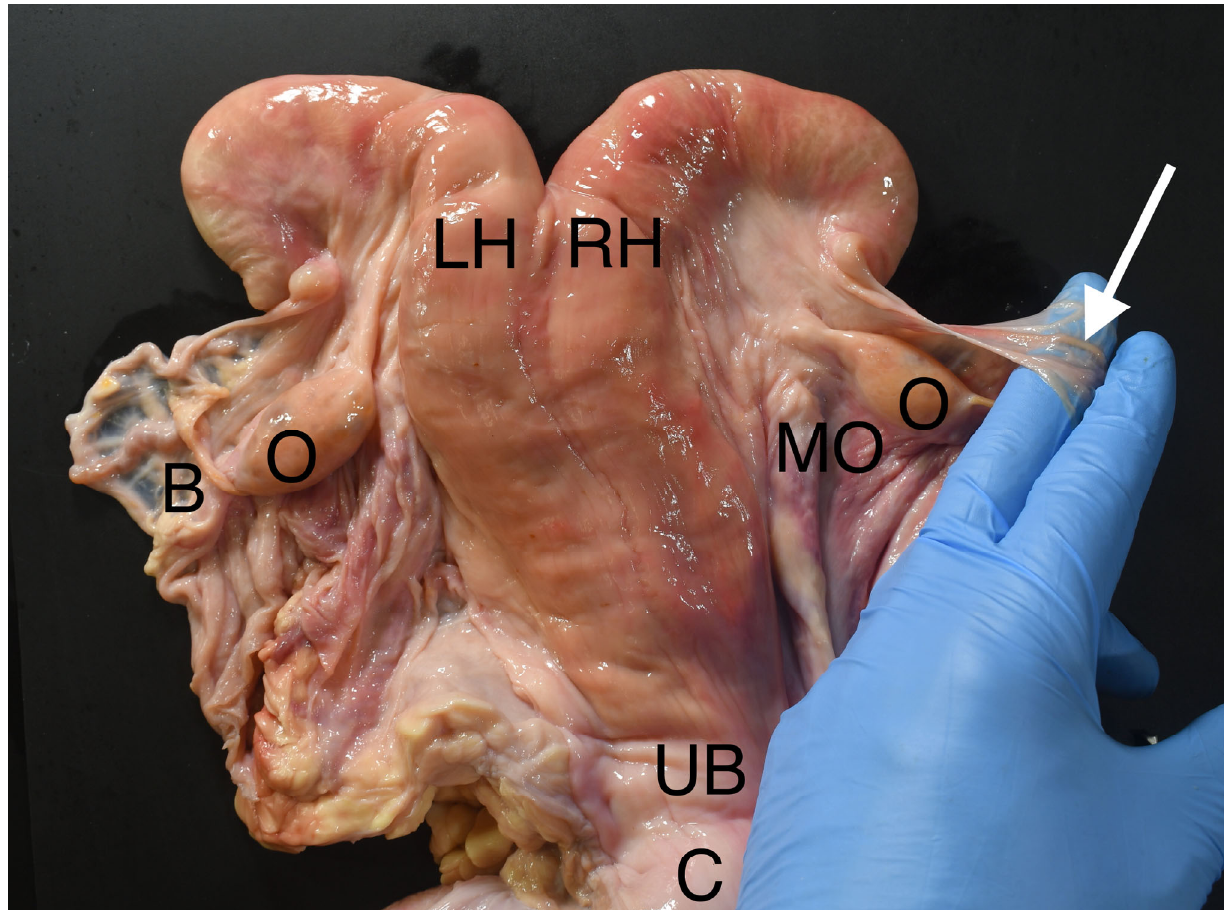
Figure 1. The uterus, ovaries and ligaments. C—Cervix; UB—Uterine body; LH, RH—Left and right uterine horns; O—Ovaries; MO—Mesovarium; B—Ovarian bursa. The arrow shows the uterine